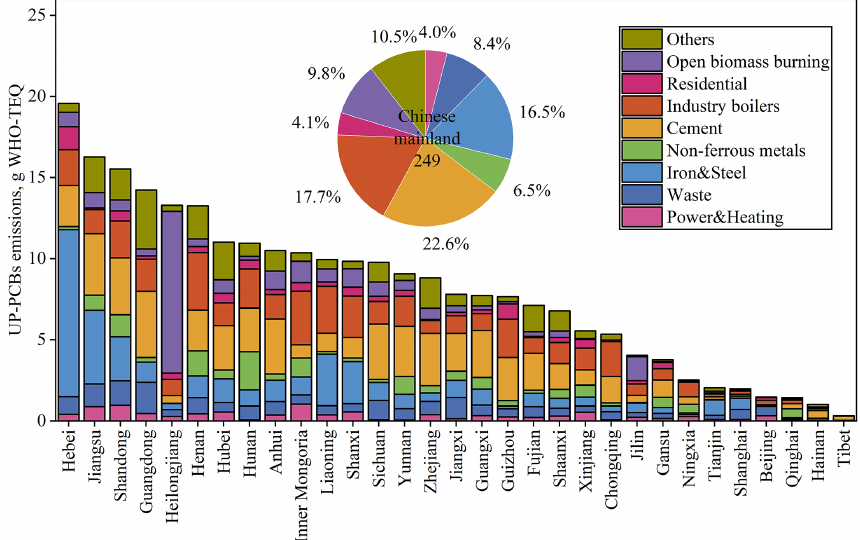
Figure 1. Total (pie chart) and provincial (columns) emissions for the Chinese mainland in